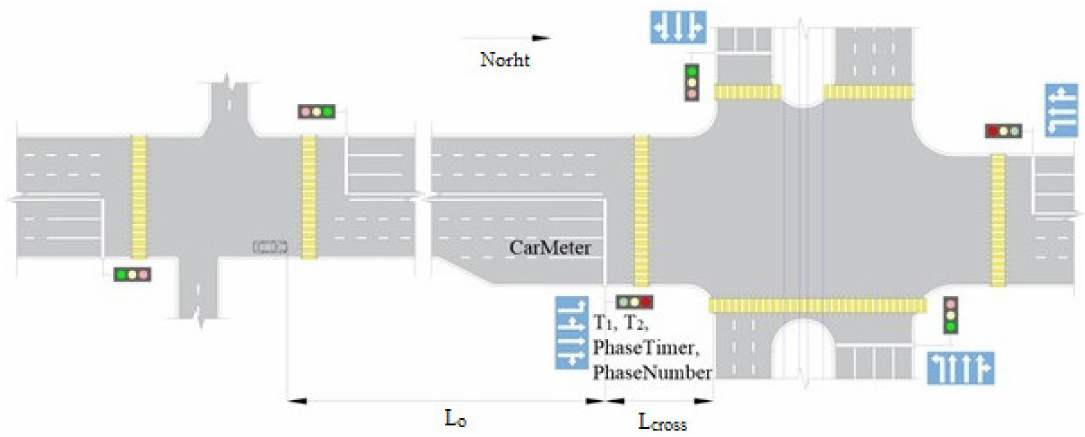
Figure 4. Traffic plan.